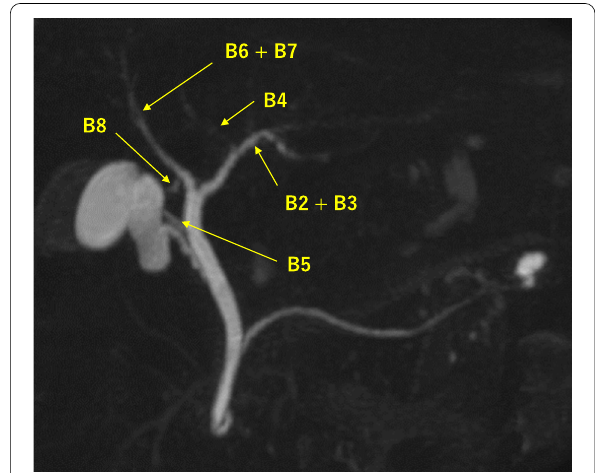
Fig. 1 A 69-year-old woman presenting with abdominal pain and gallbladder stone in ultrasound examination. Magnetic resonance